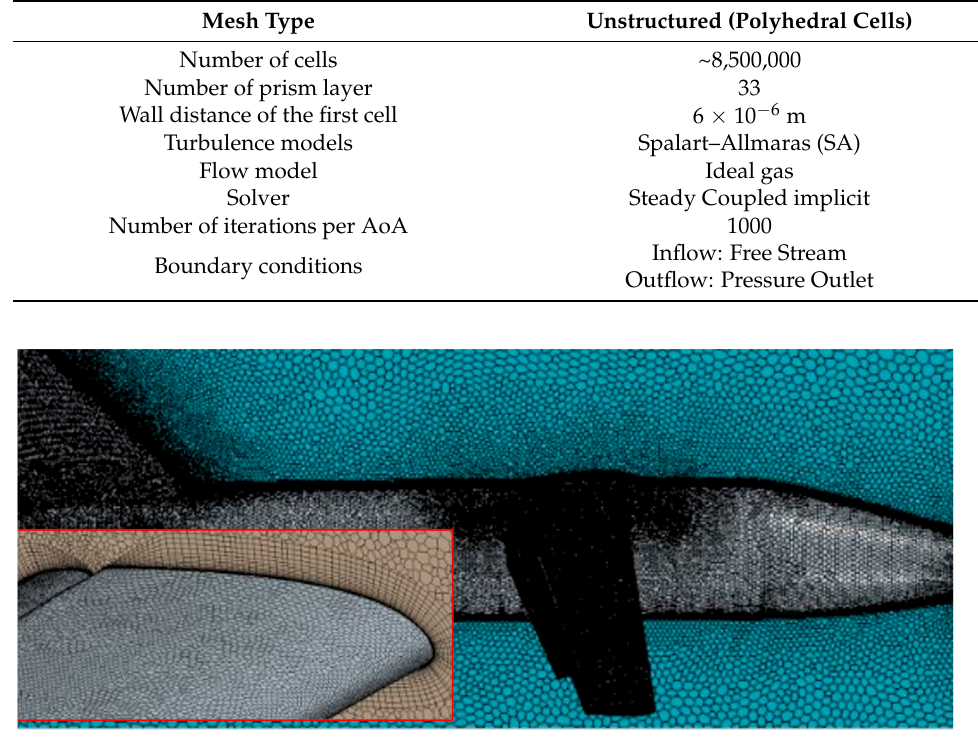
Figure 2. Polyhedral mesh: symmetry plane near aircraft. Table 2. Mesh and numerical model parameters.